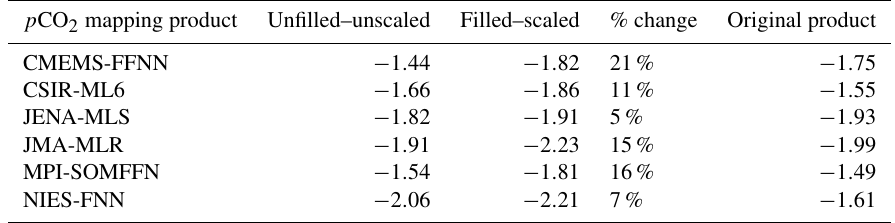
Table A3. Mean fluxes (PgCyr − 1 ) for 1990–2019 for each observational p CO 2 product. Mean flux calculated from unfilled (filled) coverage p CO 2 map and unscaled/scaled coefficient of gas transfer (unscaled = 0.251), calculated for three wind products (CCMP2, ERA5, JRA55) with the average shown here. Percent change is calculated as the difference between the unfilled–unscaled and filled–scaled as a fraction of the filled–scaled; it does not indicate an error in the product’s flux but is a representation of the impact the filling and scaling can have on the end flux estimate. The mean flux as reported in the original p CO 2 product is included for comparison (Fig.